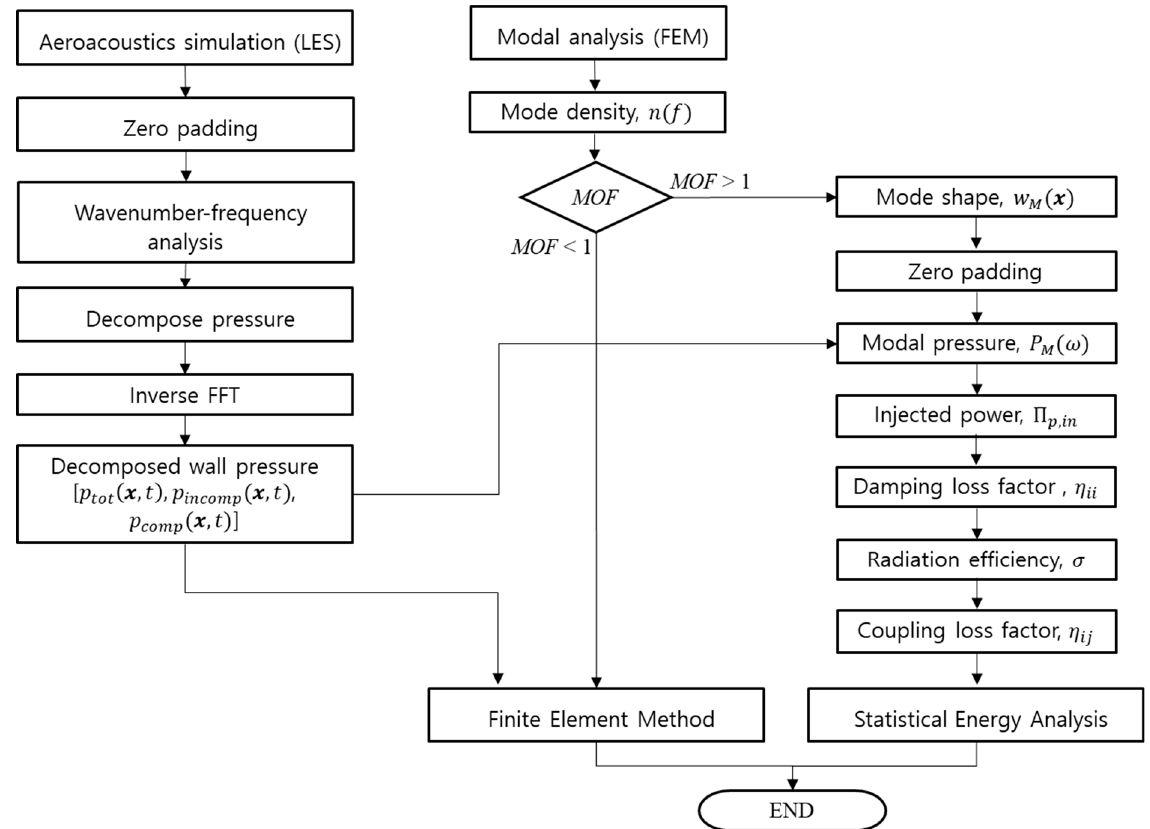
Figure 19. Workflow of the aero-vibroacoustic model.